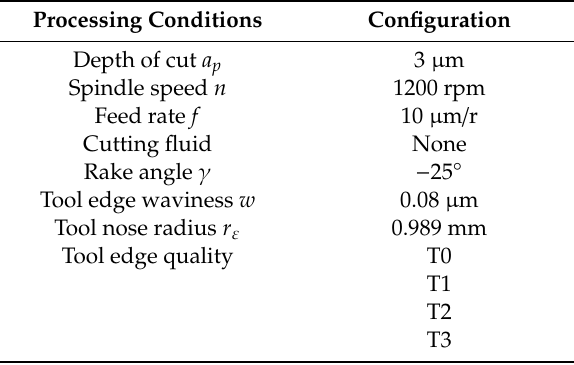
Table 2. Processing conditions used in fly-cutting experiments of KDP